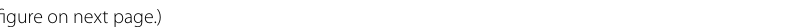
(See figure on next page.) Fig. 5 hucMSC-Exos attenuate pathological characteristics of PE rats. a Results of SBP in rats after exosome treatment. b Results of 24-h proteinuria in rats after exosome treatment. c Weight changes of fetal rats after exosome treatment. d Changes of placental weight in rats after exosome treatment. e Changes of inflammation factors after exosome treatment in serum were determined using ELISA.